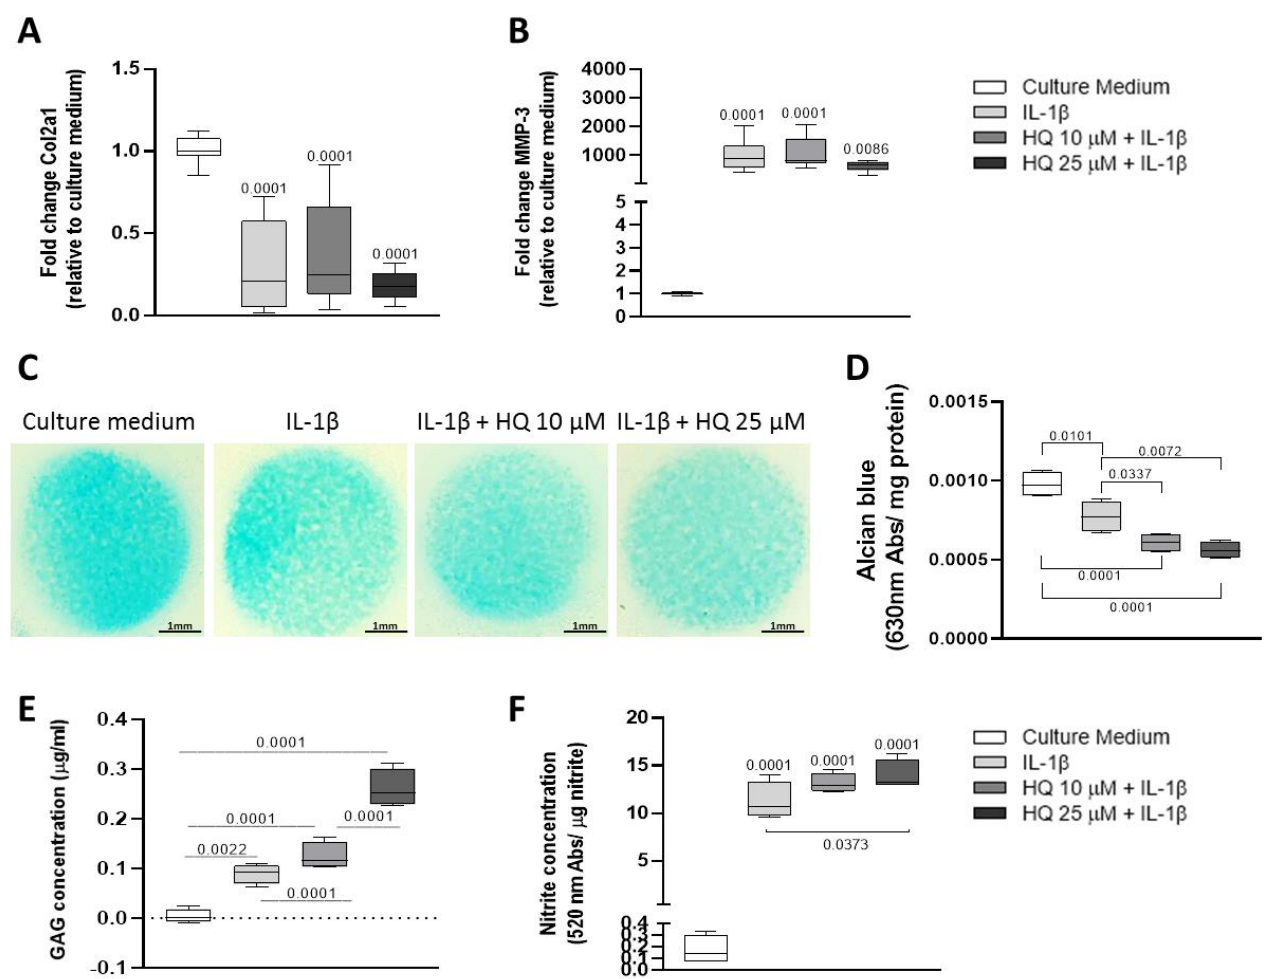
Figure 4. HQ treatment enhances the pro-catabolic activity of IL-1 β in articular chondrocytes. Pre- incubation of monolayer cultures of BACS with IL-1 β (20 ng/mL) for 4 h, did not further decrease the expression of the phenotypic marker Col2a1 ( A ) and of the catabolic enzyme MMP-3 mRNAs in cells stimulated with HQ (10 or 25 µ M) for 48 h ( B ). The co-treatment, however, reduced the accumulation of highly sulphated GAGs in chondrocyte micromasses ( C , D ) and enhanced the release of GAGs ( E ), as assessed respectively by Alcian Blue staining and DMMB assay. IL-1 β and HQ also had a combined effect in promoting nitrite production ( F ), as measured by the Griess reaction. qPCR results were normalised to the housekeeping gene β -actin and expressed as fold change to culture media. Data represent mean ± SEM from three independent experiments and were analysed with one-way ANOVA.